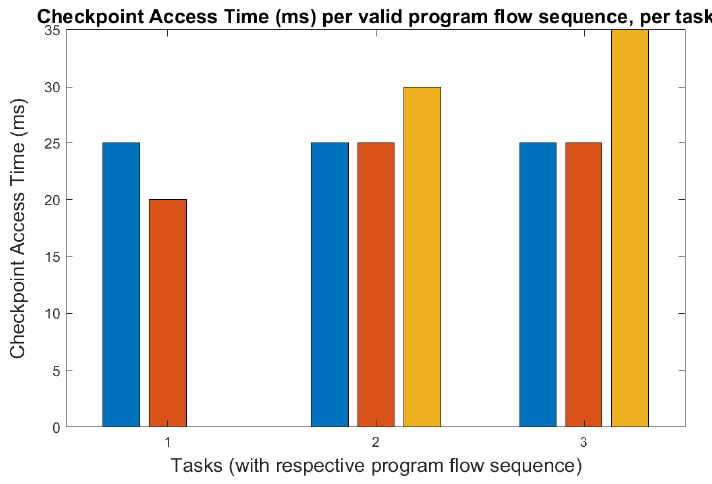
Figure 8. CP access time per program flow sequence, per